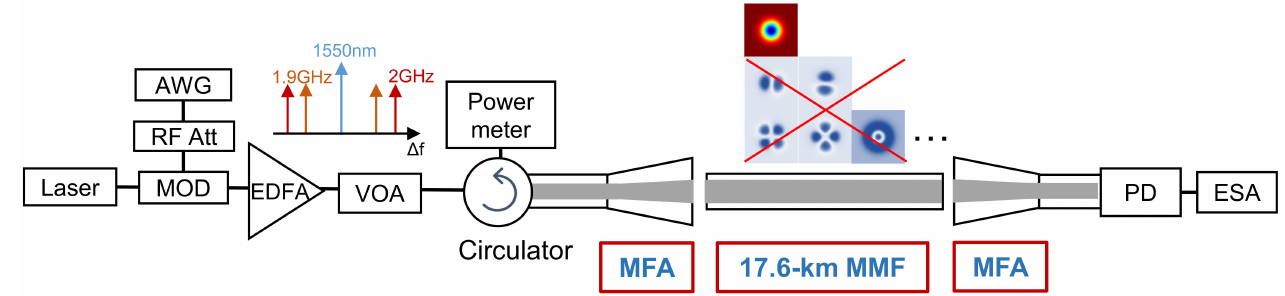
Figure 1. Schematic diagram of the microwave photonic transmission link using an MMF (OM3) with two mode field adapters, in which the large-area fundamental mode can be clearly